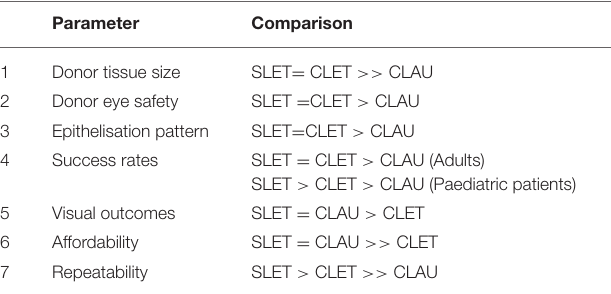
TABLE 1 | Comparison of various limbal stem cell transplantation (LSCT)